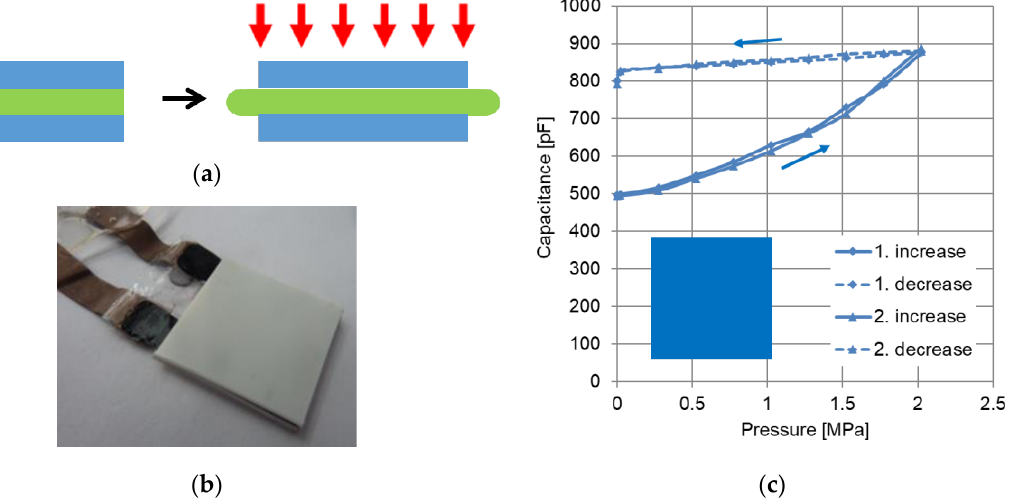
Figure 3. Scheme of the bulging of a dielectric elastomer pressure sensor with hard plates ( a ), photograph of the pressure sensor ( b ) and measured capacitance upon increase and decrease in pressure in two cycles ( c ) [97].